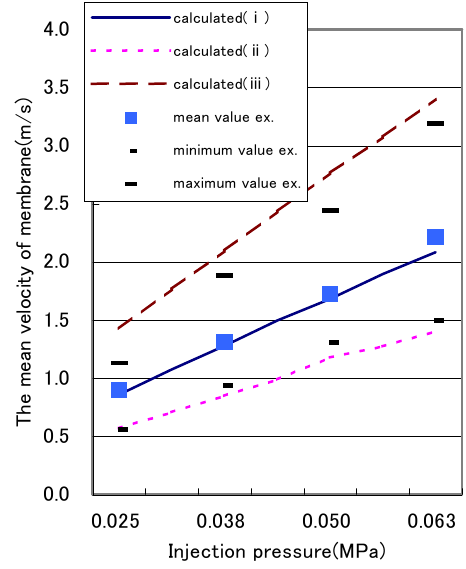
Fig. 13 Comparison of experimental velocity with calculated ones (initial inner radius,( ⅰ )0.75mm,( ⅱ )0.65mm,( ⅲ